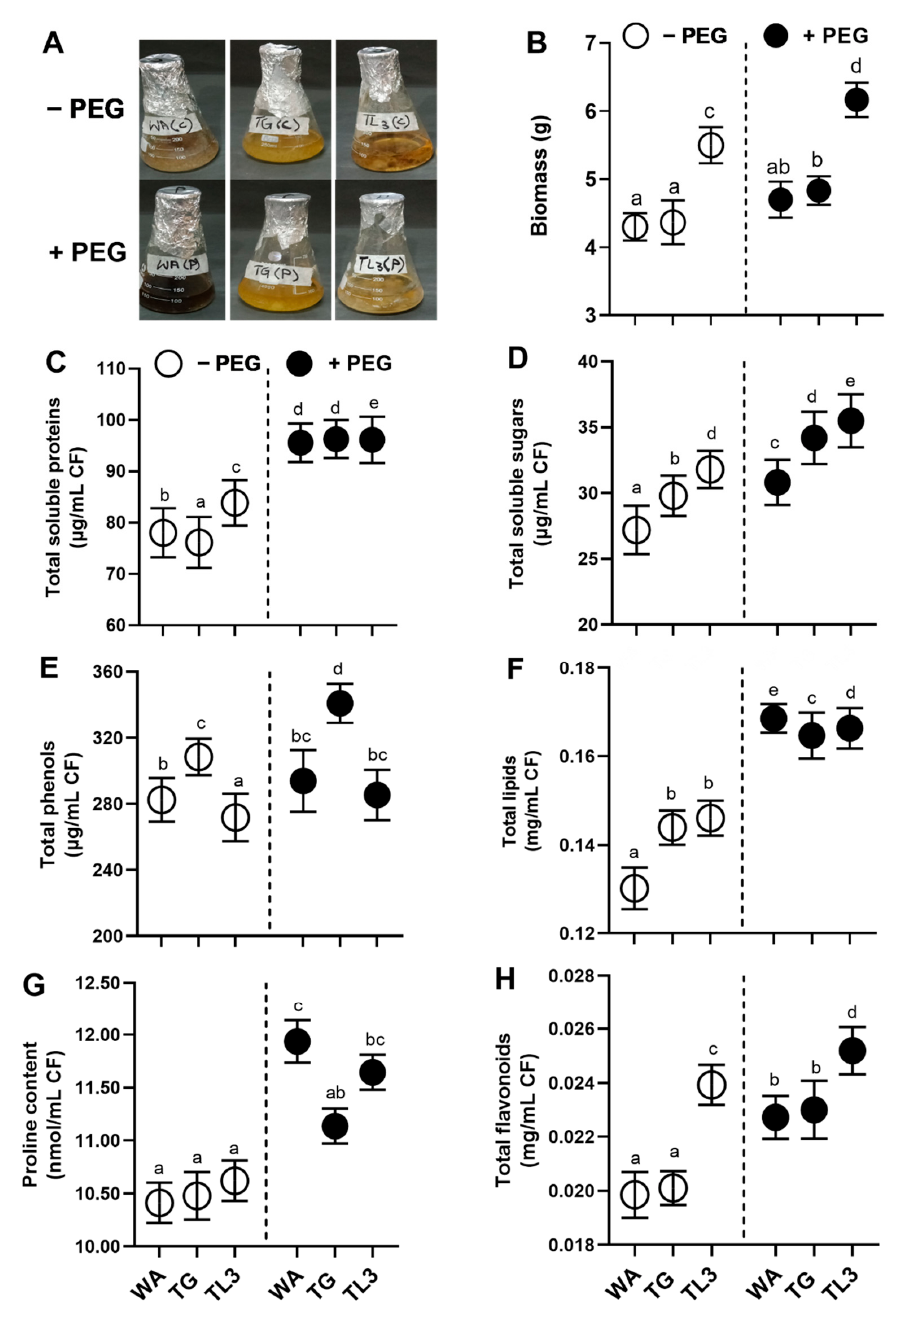
Figure 2. Characterization of fungal isolates. ( A ) Screening of fungal strains with 8% PEG in czapek media compared to control (0% PEG). ( B ) Biomass, ( C ) total soluble proteins, ( D ) total soluble sugars, ( E ) total lipids, ( F ) total phenols, ( G ) total flavonoids, and ( H ) proline content measured in CF of fungal isolates. Quantitative data represent means ± SE of three independent biological replicates presented with various letters showing differences at a significance level of p ≤ 0.05 using Duncan’s multiple range test (DMRT). CF; culture filtrate.